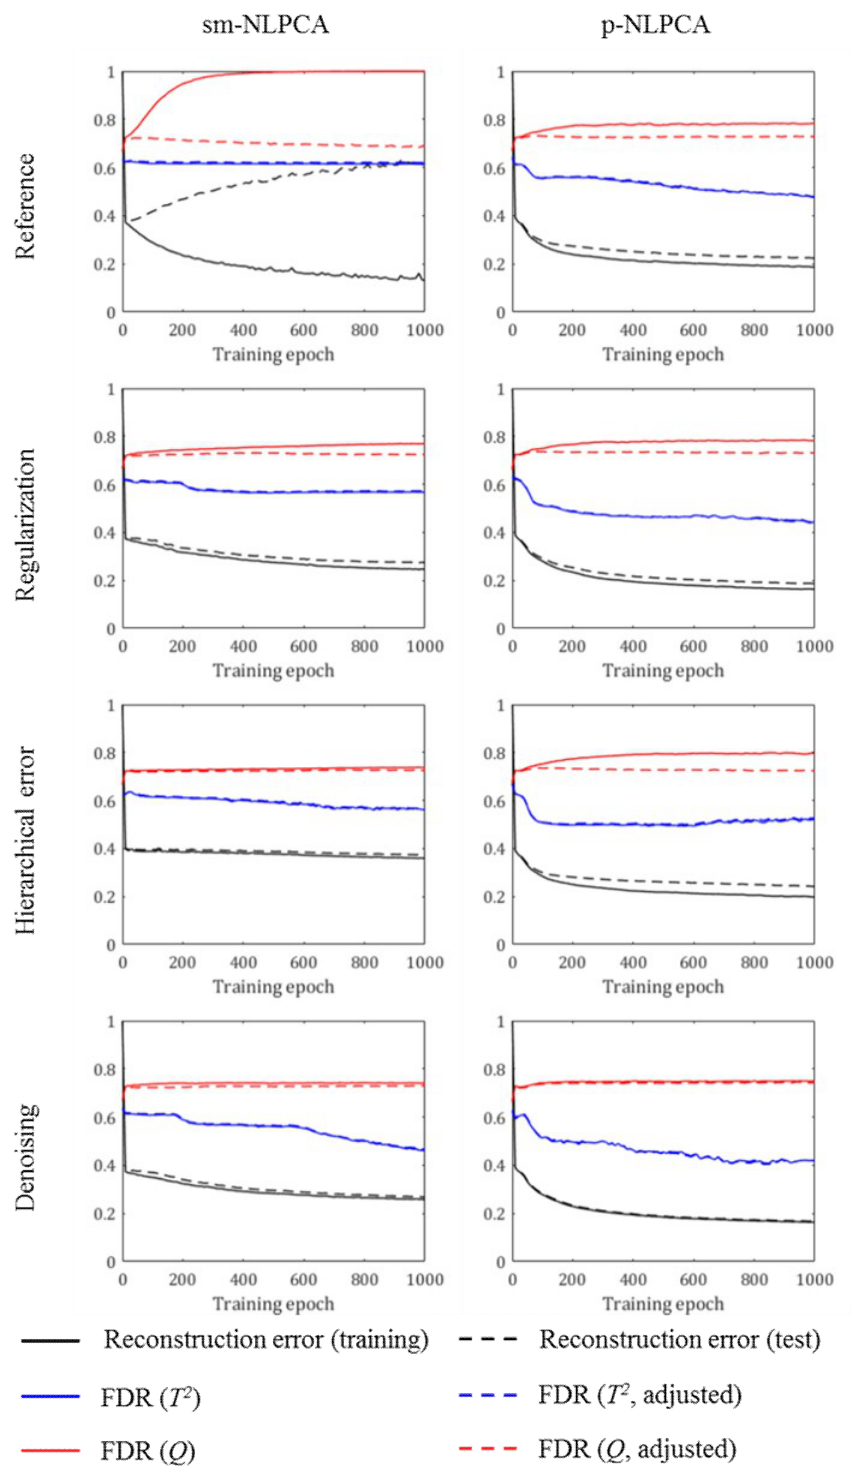
Figure 4. Change in the process monitoring results with respect to the training epoch.